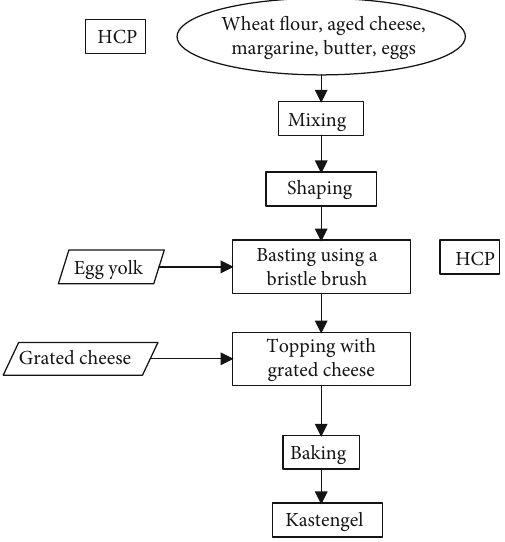
Figure 4: The production process of kastengel and its